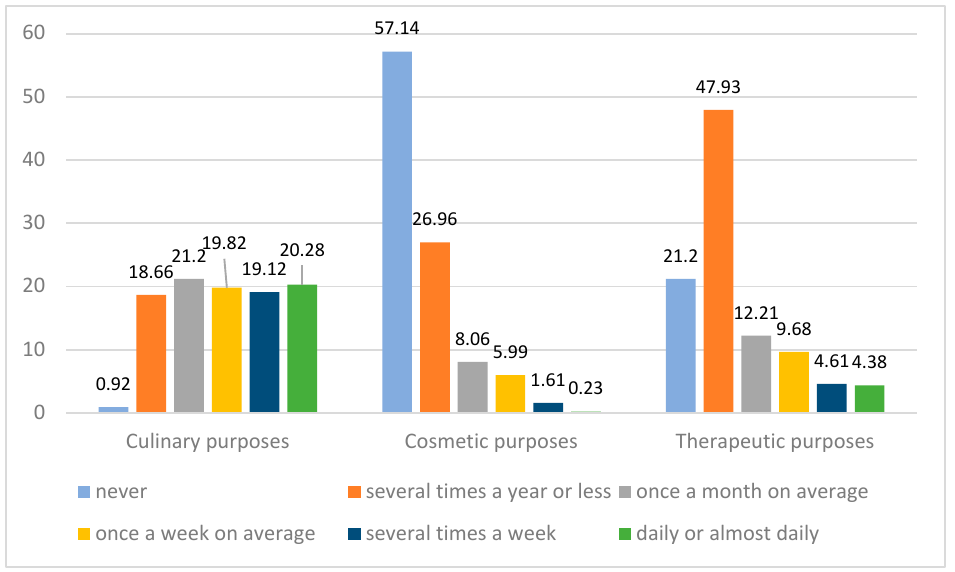
Figure 3. Ways of culinary use of honey (n = 483, data in %). For cosmetic purposes, honey users (n = 209) are most likely to use it to moisturise the skin (23% at least once a month), to soothe irritation (19.1%), to cleanse the skin (18.25), to improve skin elasticity (17.7%), and to stop the ageing process (16.8%). Honey is least frequently used for anti-acne therapy and skin cleansing, with 74.6% and 65.1% of re- spondents declaring that they never use honey for these purposes (Figure 4).